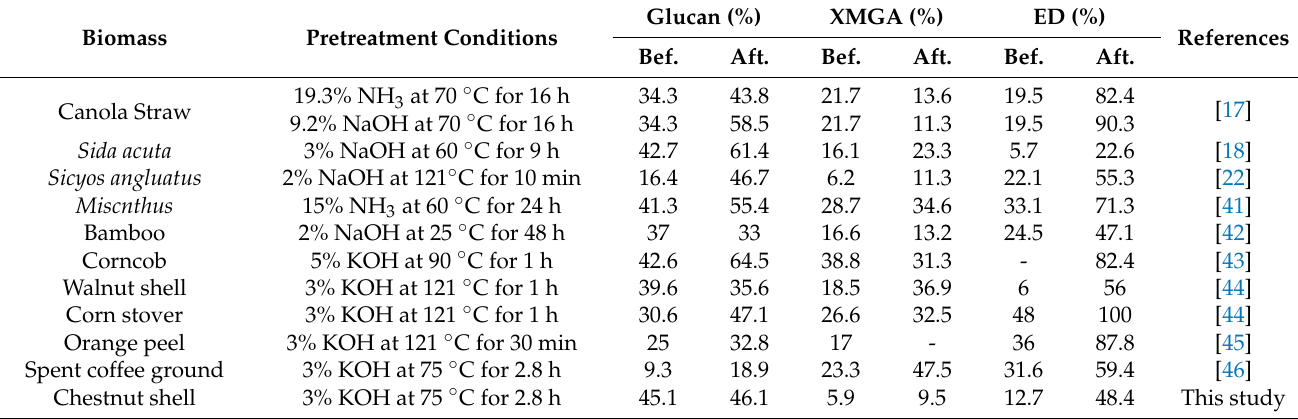
Table 7. Summary of changes in the chemical properties of various biomass by alkali pretreatments.